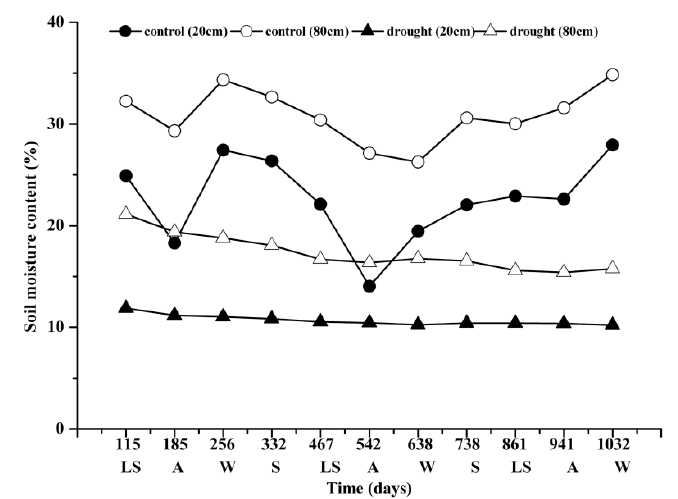
Figure 1. Bagnouls–Gaussen bio-climatic diagram.